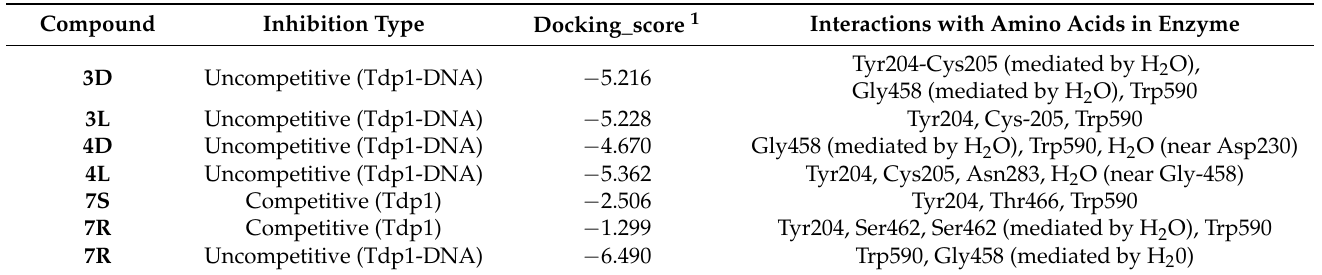
Table 2. Binding energy evaluation and interactions with amino acid residues for chiral nucleoside Tdp1